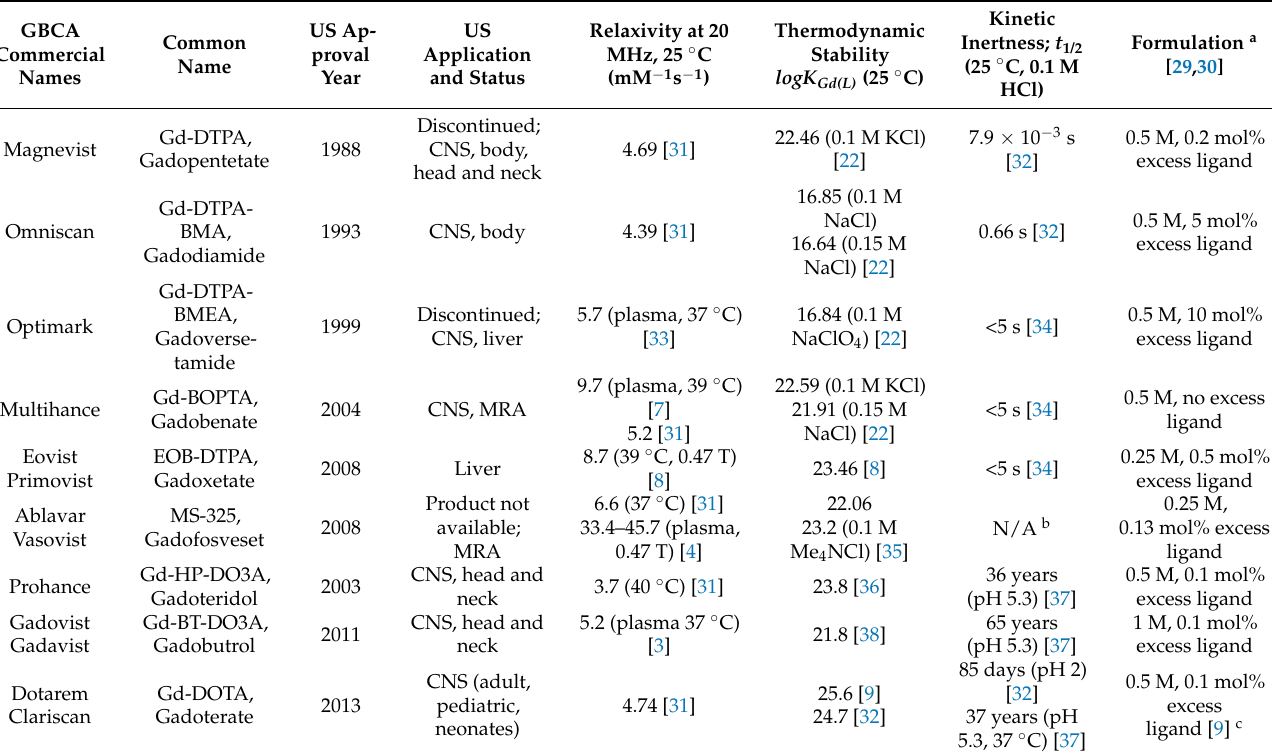
Table 1. Properties of approved GBCA. The t 1/2 values were calculated for the specific acidic condition of [HCl] = 0.1 M HCl: linear agent condition also has [Zn 2+ ] and [Cu 2+ ] to account for metal exchange